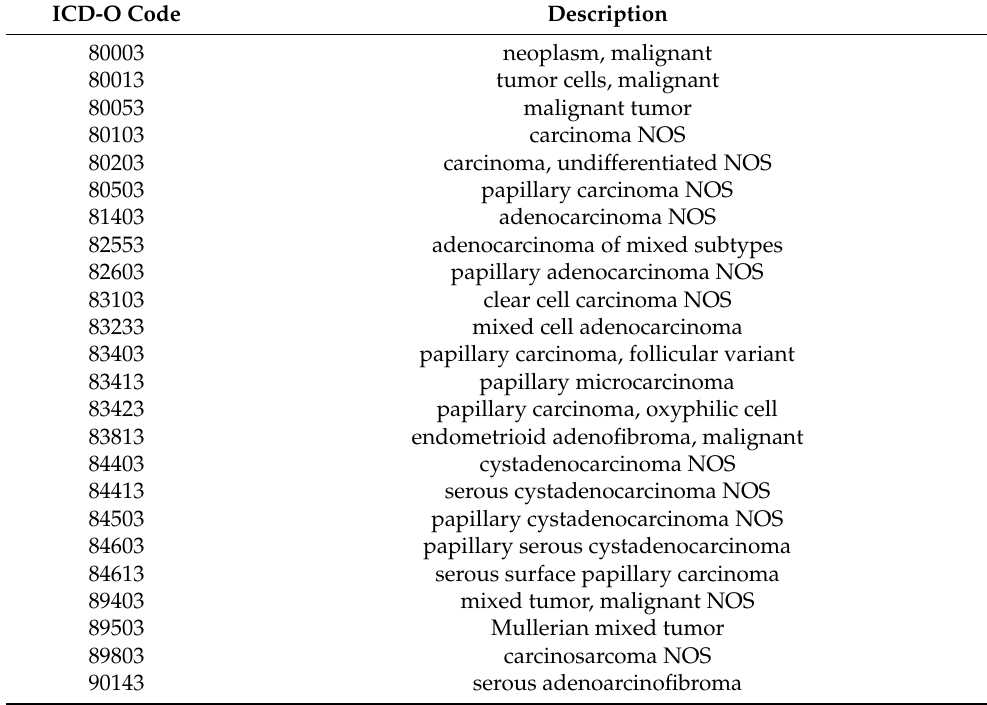
Table A3. ICD-O codes included for high grade